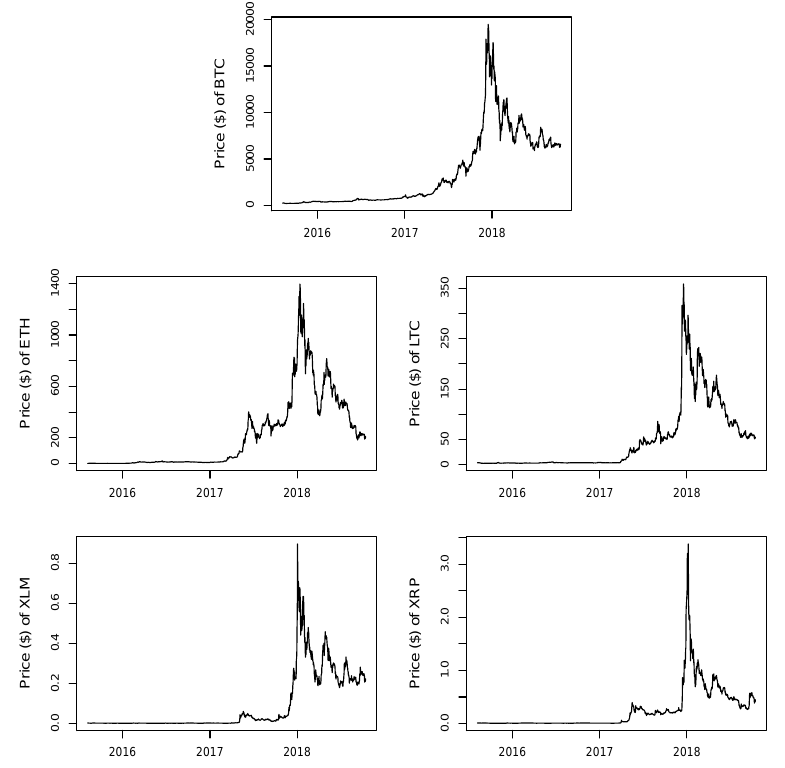
Figure 1. Prices of the five cryptocurrencies from 8 August 2015 to 15 October 2018. Table 1. Descriptive statistics of the five cryptocurrencies. The sample consists of 1165 daily log-returns of the five cryptocurrencies from 8 August 2015 to 15 October